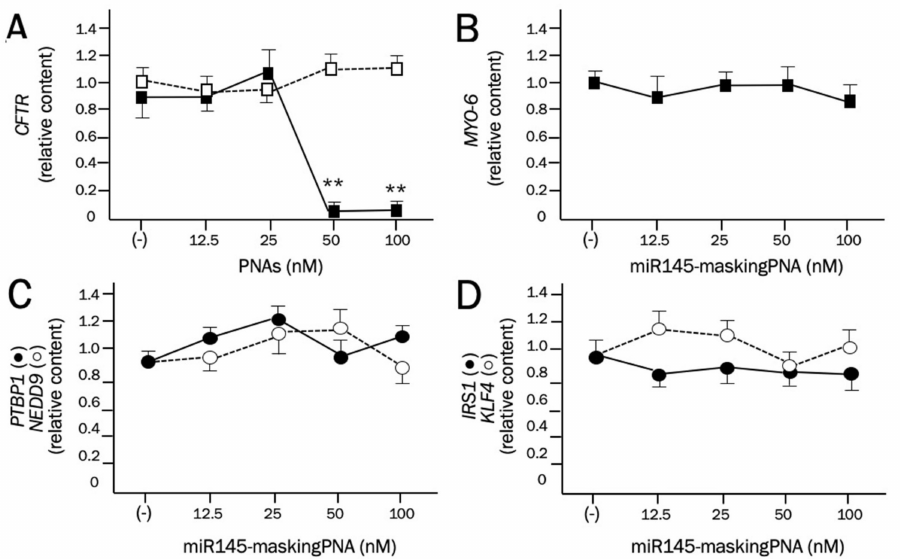
Figure 3. E ff ects of the miR145-maskingPNA on the RT-PCR amplification of 3 (cid:48) UTR mRNA sequences. ( A ). E ff ects of the miR145-maskingPNA (black symbols) and of the negative control PNA (white symbols) on the amplification of CFTR mRNA sequences. Inhibition by miR145-maskingPNA is clearly seen at 50 nM. The negative control PNA was not e ff ective. E ff ects of the miR145-maskingPNA on the amplification of Myosin-6 ( B ), PTBP1 (polypyrimidine tract binding protein 1) and NEDD9 (neural precursor cell expressed, developmentally down-regulated 9) ( C ), IRS1 (insulin receptor substrate 1), and KLF4 (Kruppel-like factor 4) ( D ) mRNAs. No PCR inhibition in any of these examples was appreciable even at the highest concentrations